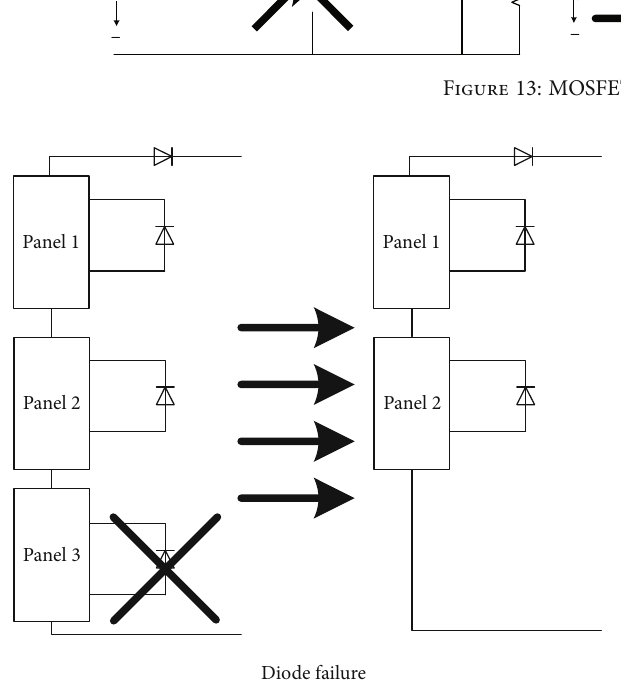
Figure 14: A panel bypass diode ’ s failure.